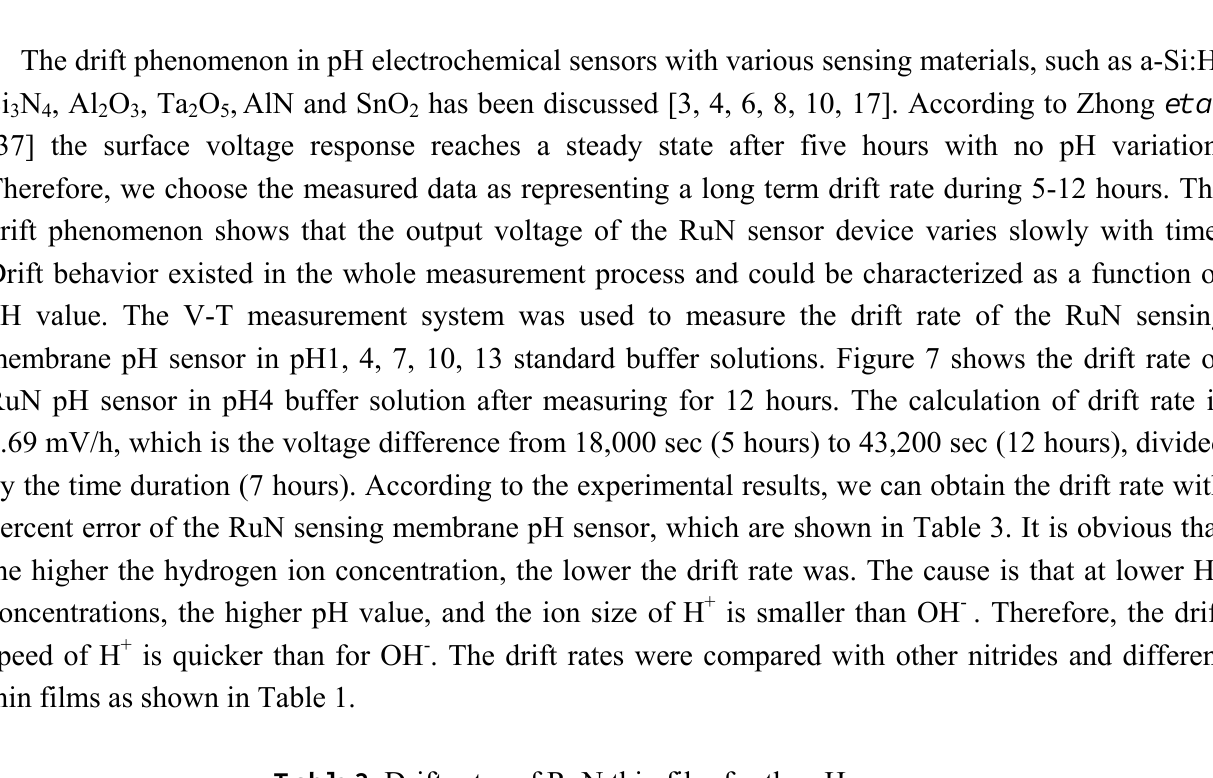
Table 3. Drift rates of RuN thin film for the pH sensor.